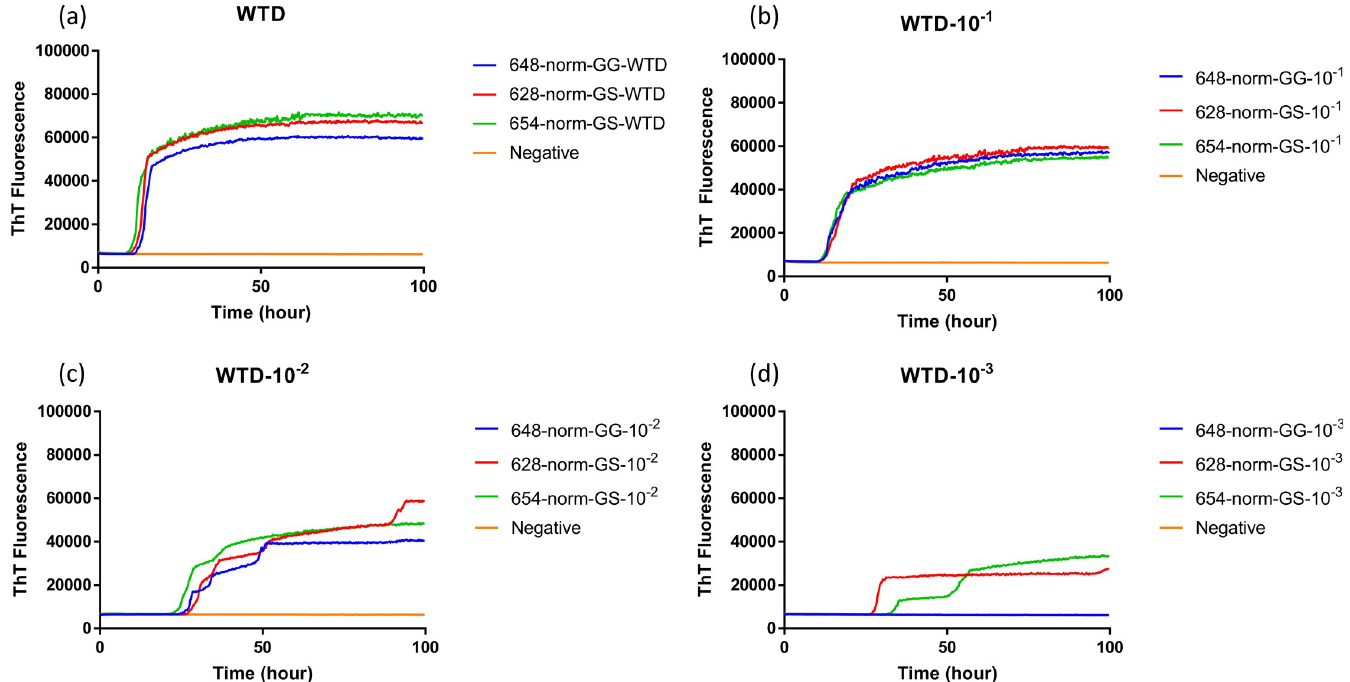
Fig 1. RT-QuIC reactions seeded with CWD infected or not infected white tailed deer brains using BV rPrP as a substrate. RT-QuIC reactions were seeded with EIA normalized stock (a), 10 − 1 (b), 10 − 2 (c), and 10 − 3 (d) dilutions of three CWD infected WTD brains and one negative animal. All reactions were seeded with brain homogenates of WTD with the addition of 0.001% of SDS. Shown are the average ThT fluorescence readings (thick lines) with standard deviations (thin lines) determined from all replicates (four replicate reactions per each animal).